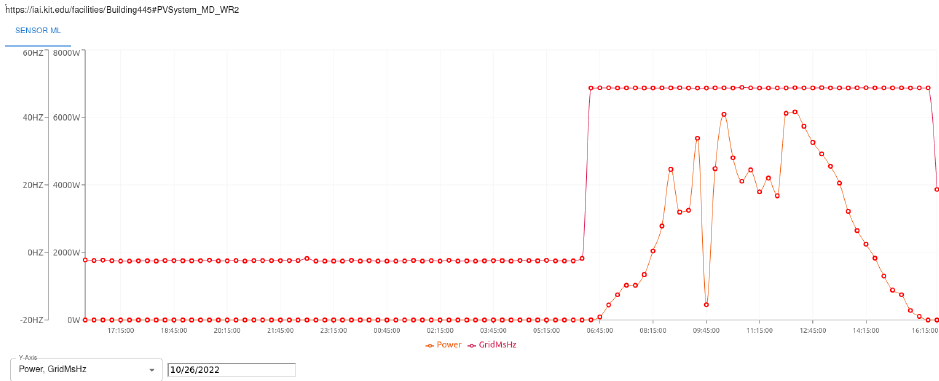
Figure 8. Screenshot of the SensorML Plugin Visualizing Power and Grid Frequency